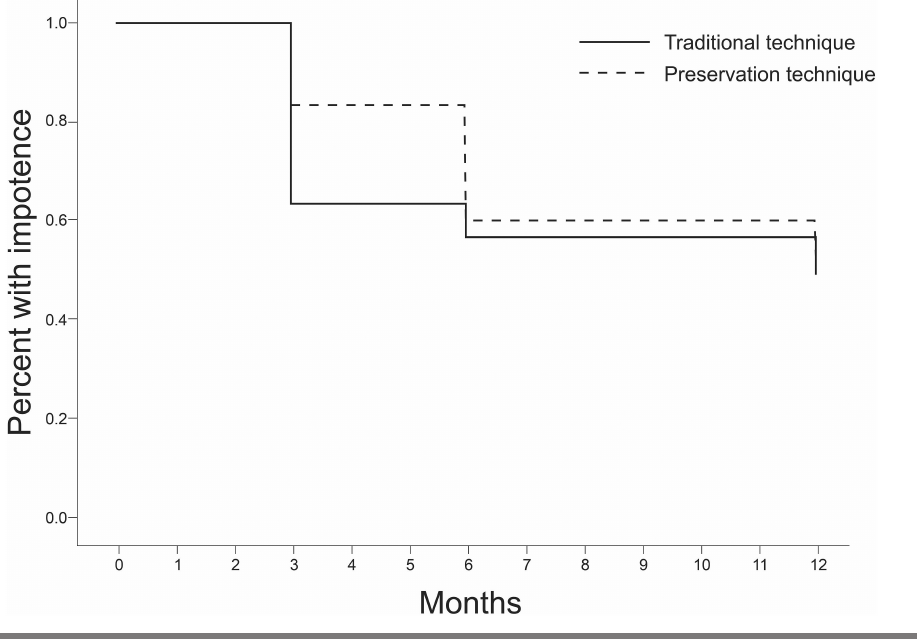
Figure 4. Kaplan–Meier curves of